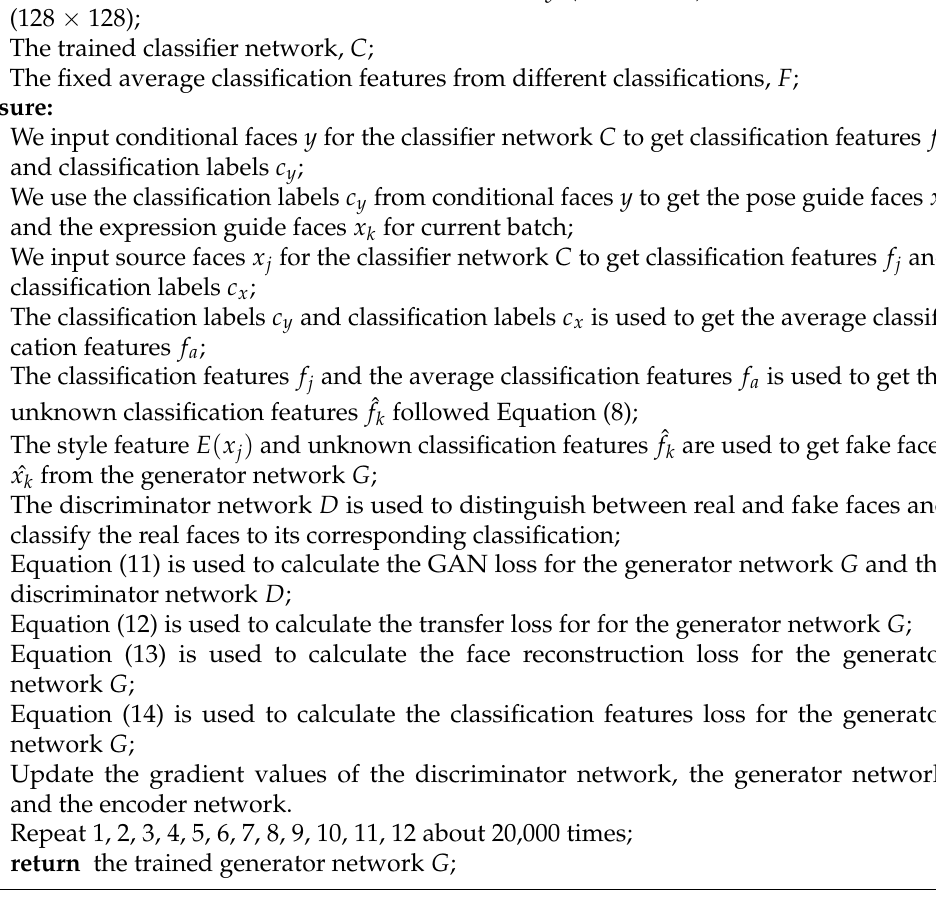
Algorithm 1 Facial pose and happy expression transfer